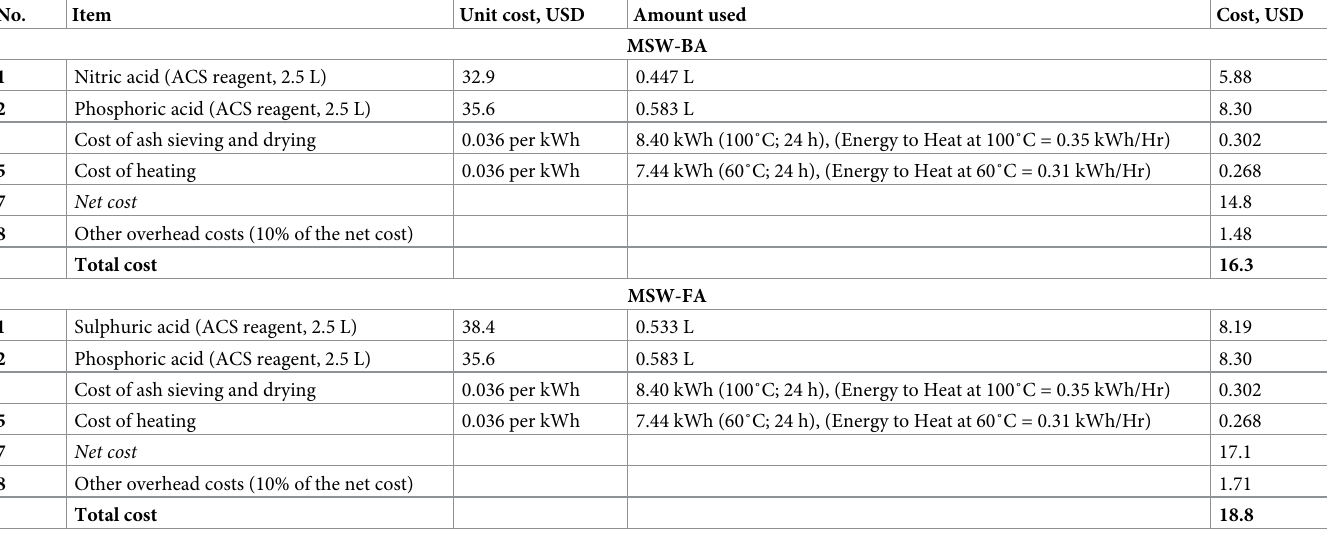
Table 5. Breakup and total cost required of metal extraction for 1 kg of the MSW-BA and the MSW-FA.